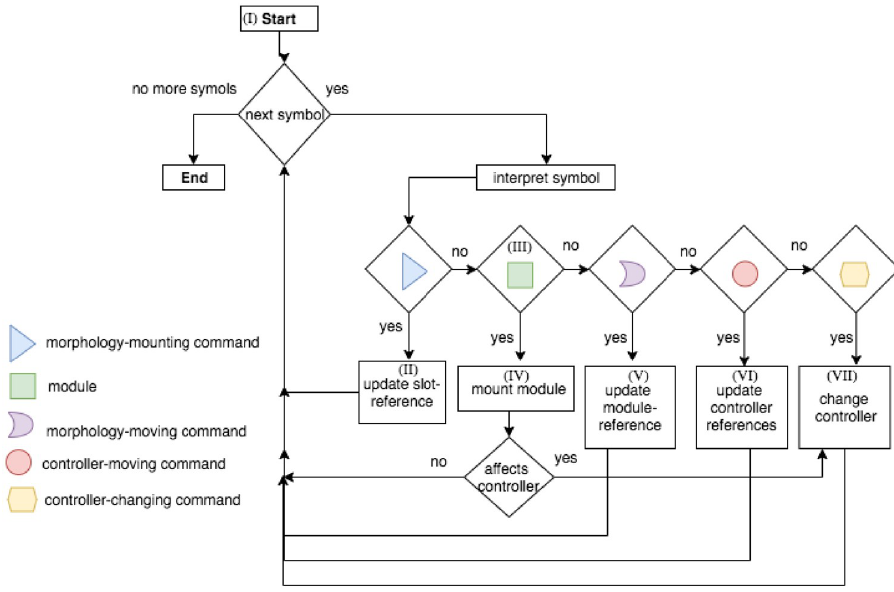
Fig 2. Fluxogram of the late-development process. From the left to right of the string, each symbol of the early- developed phenotype (string) goes thorough this process, being interpreted and developed (or not expressed).